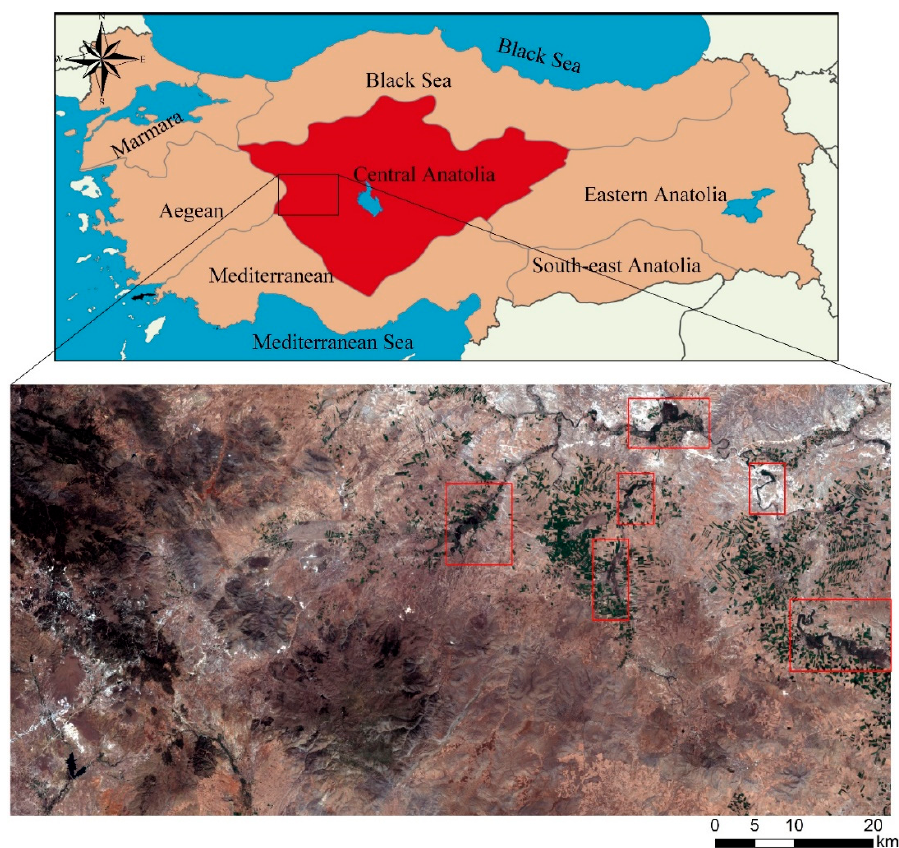
Figure 1. General view of the study